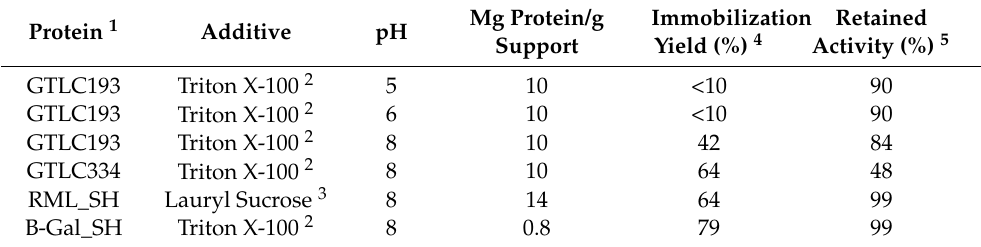
Mg Protein/g Support